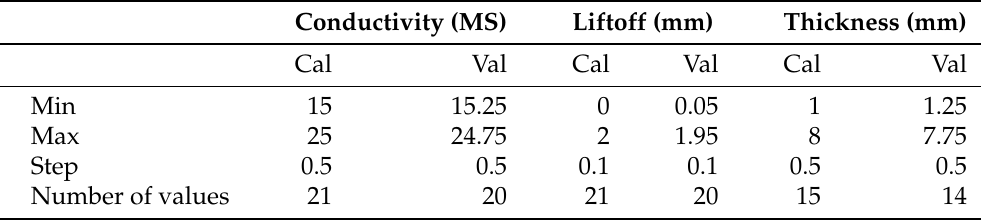
Table 2. Parameters for simulation of the eddy-current testing (ECT)